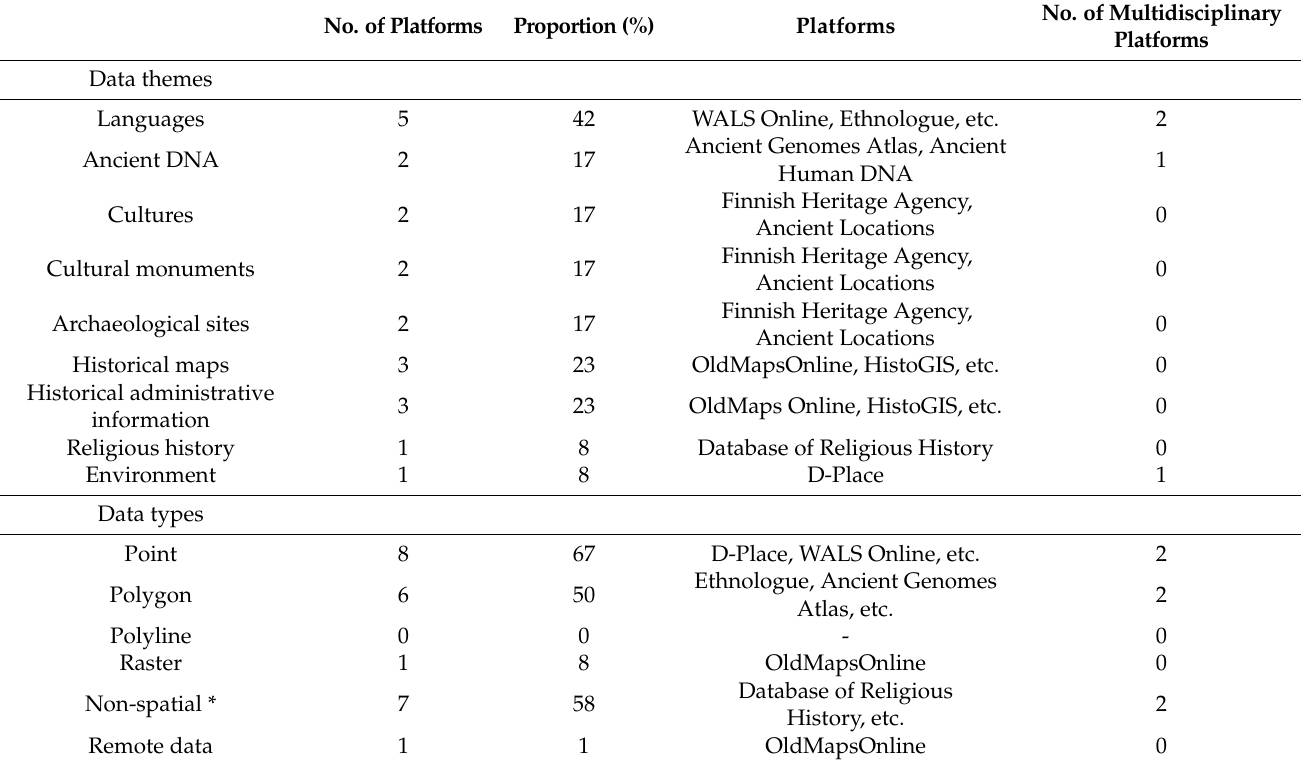
Table 3. Themes and types of data in our historical spatial data platform